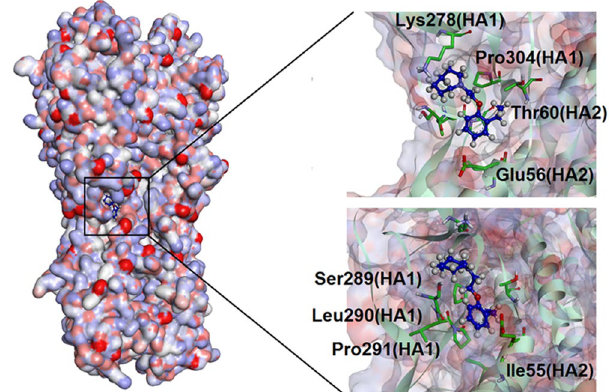
Figure 9. Predicted new binding modes of INT-HA 1ruz under acidic conditions.